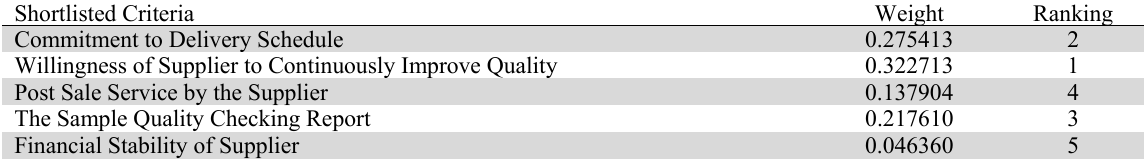
Ranking of the shortlisted criteria using AHP Shortlisted